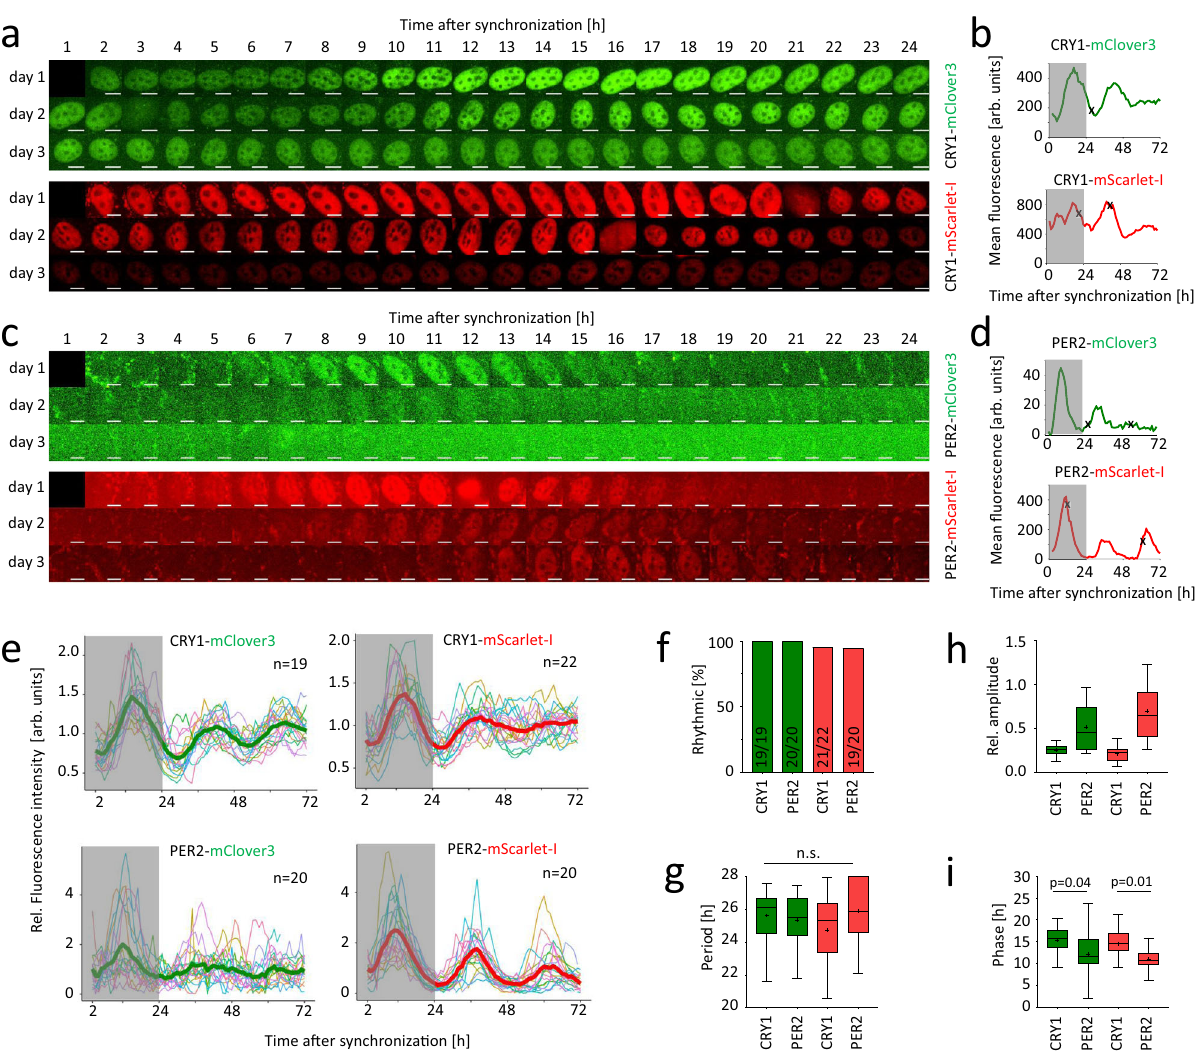
Fig. 2 PER2- and CRY1-fusion protein oscillate in single knock-in cells. a , c Montage of fl uorescence microscopy images of selected individual U-2 OS single knock-in cells ’ nuclei over the course of 3 days after synchronization. b , d Mean of nuclear fl uorescence intensity (background-subtracted) quanti fi ed from ( a ) and ( c ). Cell division marked by (x). e Time series of normalized mean nuclear fl uorescence in individual knock-in cells with average signal overlaid in bold. f Percentage of signi fi cantly rhythmic time series from ( e ). g – i Extracted rhythm parameters of signi fi cantly rhythmic single-cell time series from e (n = individual cells as stated in f ). p-values: one-way ANOVA, two-sided. Scale bar: 10 µ m. Boxplots: box: interquartile range, center: median, whiskers: minimum to maximum, mean is marked with ( + ). In b , d and e , the fi rst 24 hours after synchronization (possible acute response